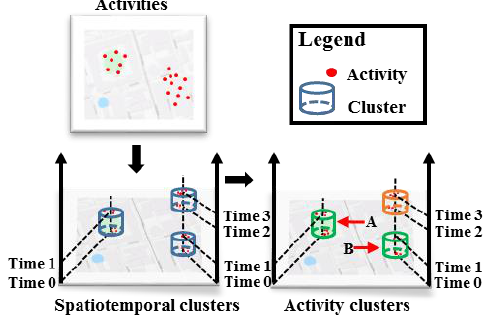
Figure 2 Clustering workflow. The spatiotemporal clusters having similar semantic patterns are highlighted in the same colour. Therefore, spatiotemporal cluster A and B are similar in terms of semantics and time period, which can be grouped as the same type of activity